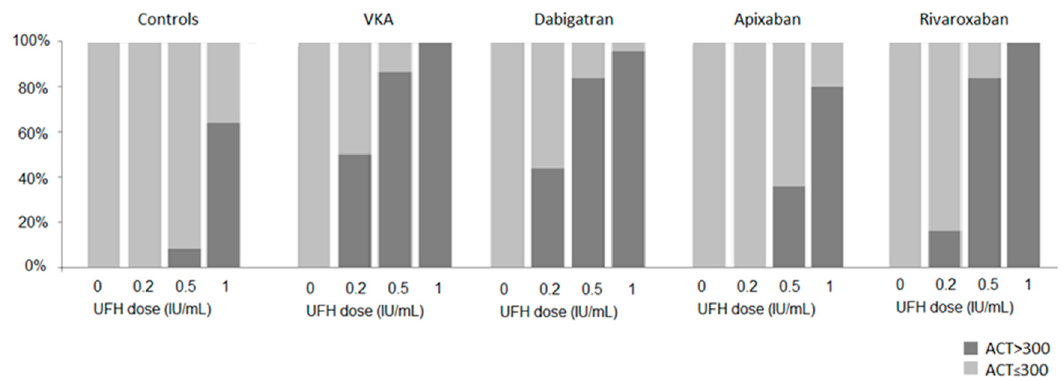
Figure 3. Percentage of patients achieving the ACT target ≥ 300 s in response to each UFH dose, according to the oral anticoagulant on board.